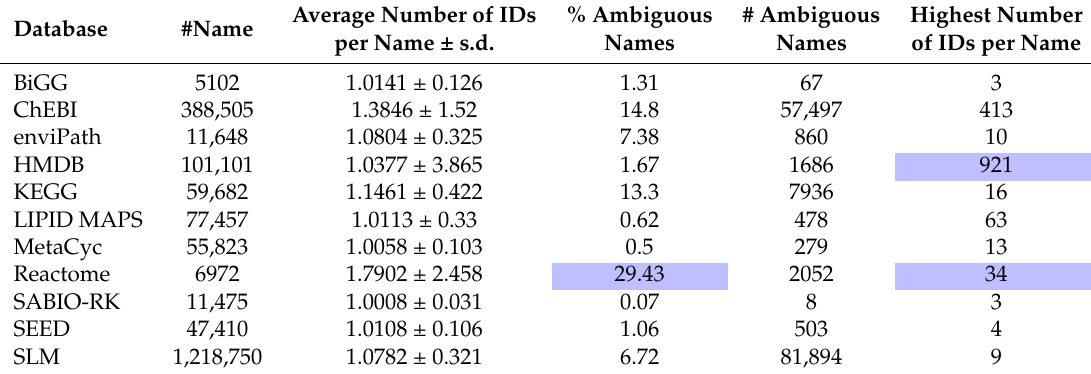
Table 1. Ambiguity in biochemical database: number of compound names associated with more than one identifier (ID.) s.d. stands for standard deviation. Blue boxes are used to highlight highest